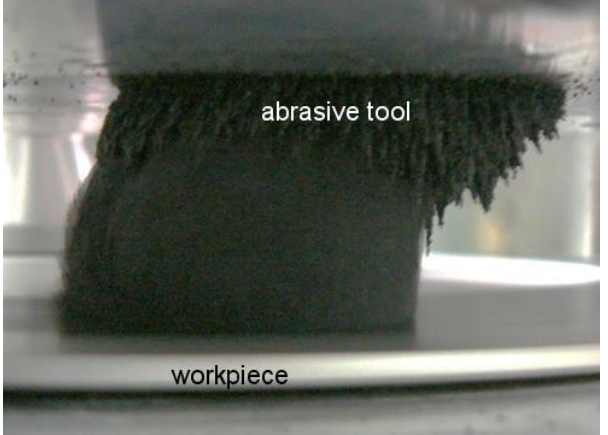
Figure 30. Migration of abrasive grains outside the machining zone during processing.